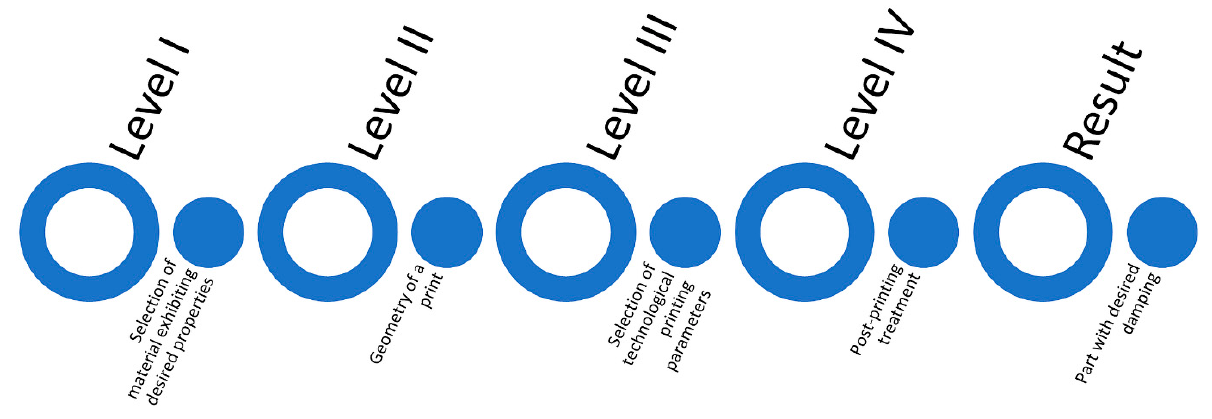
Figure 3. Multilevel design and manufacturing process